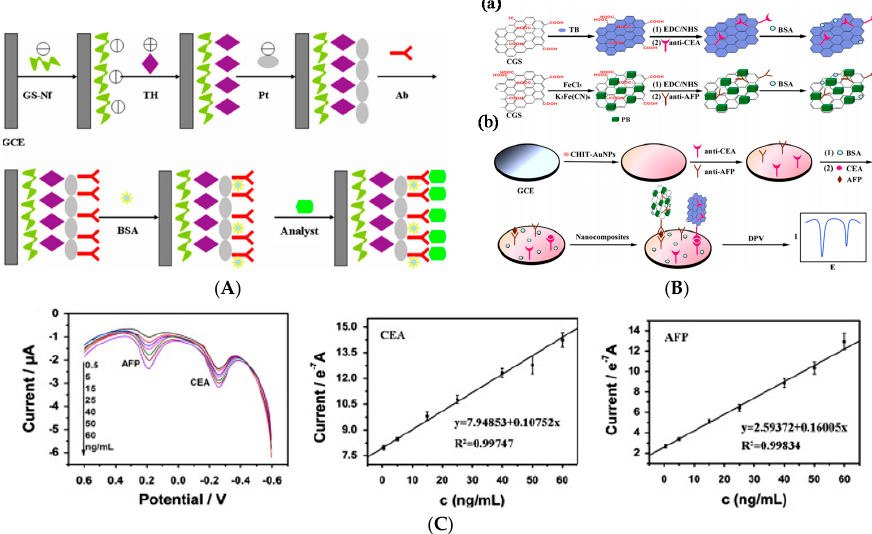
Figure 13. ( A ) Ab/PtNPs/Thi/Nafion/GR/GC electrode for detection of kanamycin. Reprinted from [71], Copyright 2012, with permission from Elsevier; ( B ) Antibody-modified and Prussian blue-modified GO ( a ) and multiplexed electrochemical immunoassay protocol for CEA and AFP detection ( b ); ( C ) Left: DPV responses of the immunosensor after incubation with CEA and AFP; center and right: corresponding calibration curves. Reprinted from [77], Copyright 2013, with permission from Elsevier.